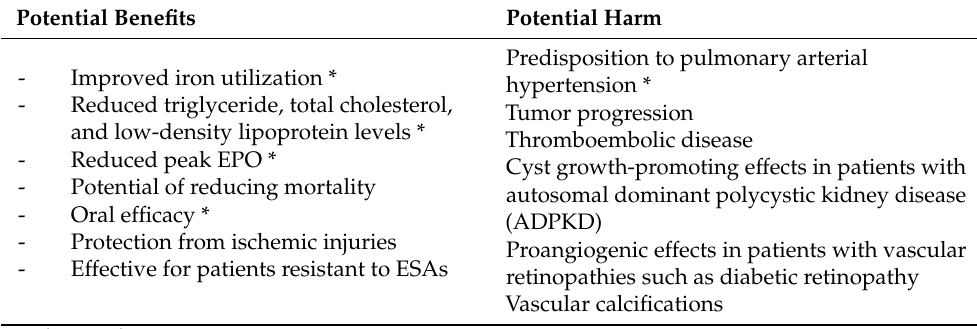
Table 3. Potential advantages and disadvantages of HIF-PHIs [5,104–111].